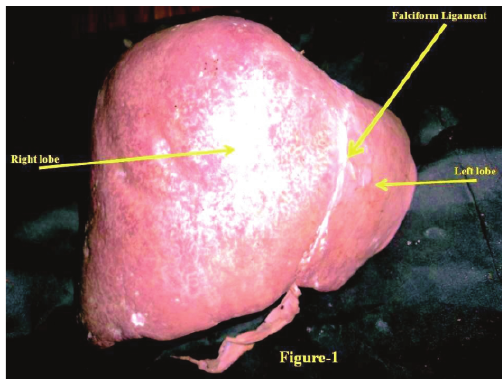
Figure 1: It shows anterosuperior view of liver.